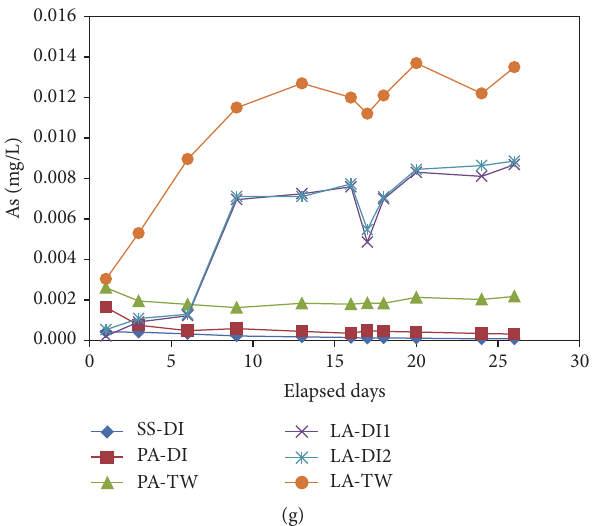
Figure 6: (a) Cu, (b) Zn, (c) Cd, (d) Co, (e) Ni, (f) Mn, and (g) As concentrations measured over time for each